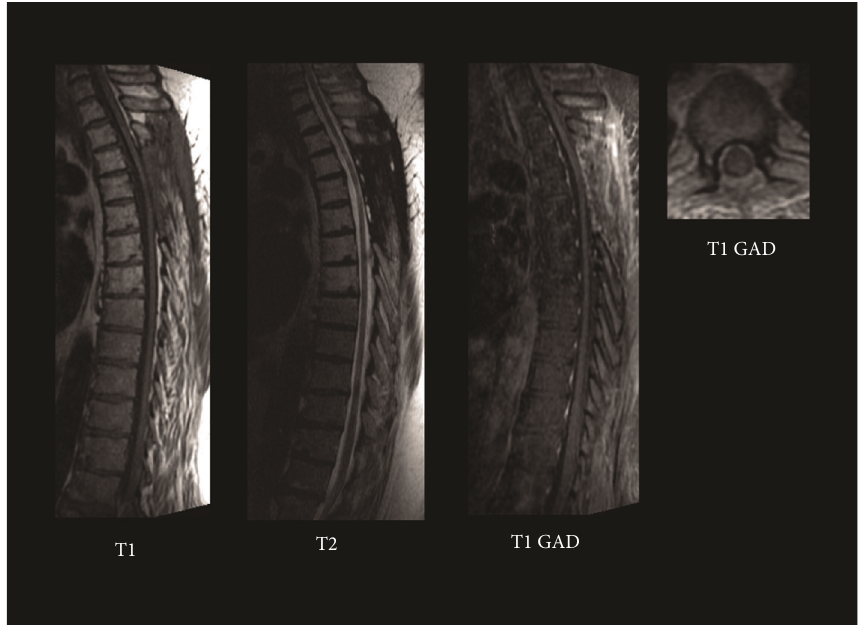
Figure 3: Postoperative MRI at 1-year followup shows 3 sagittal sequences (T1, T2, and T1 with gadolinium) on the left and an axial (T1 with gadolinium) on the right demonstrating no evidence of tumor